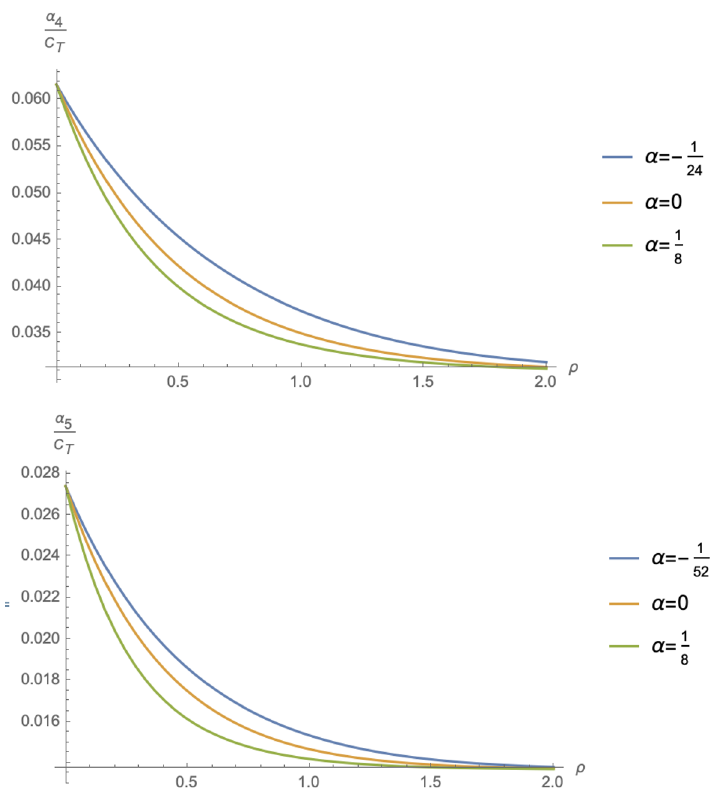
Figure 2 . Casimir coefficient α d for d = 4 (above) and d = 5 (below). The blue line, orange line and green line correspond to the lower bound, zero and the upper bound of the Gauss-Bonnet coupling α . The Casimir coefficient α d is positive and decreases with the brane tension ρ . The smaller α is, the larger α d /C T is, where C T is the central charge defined by